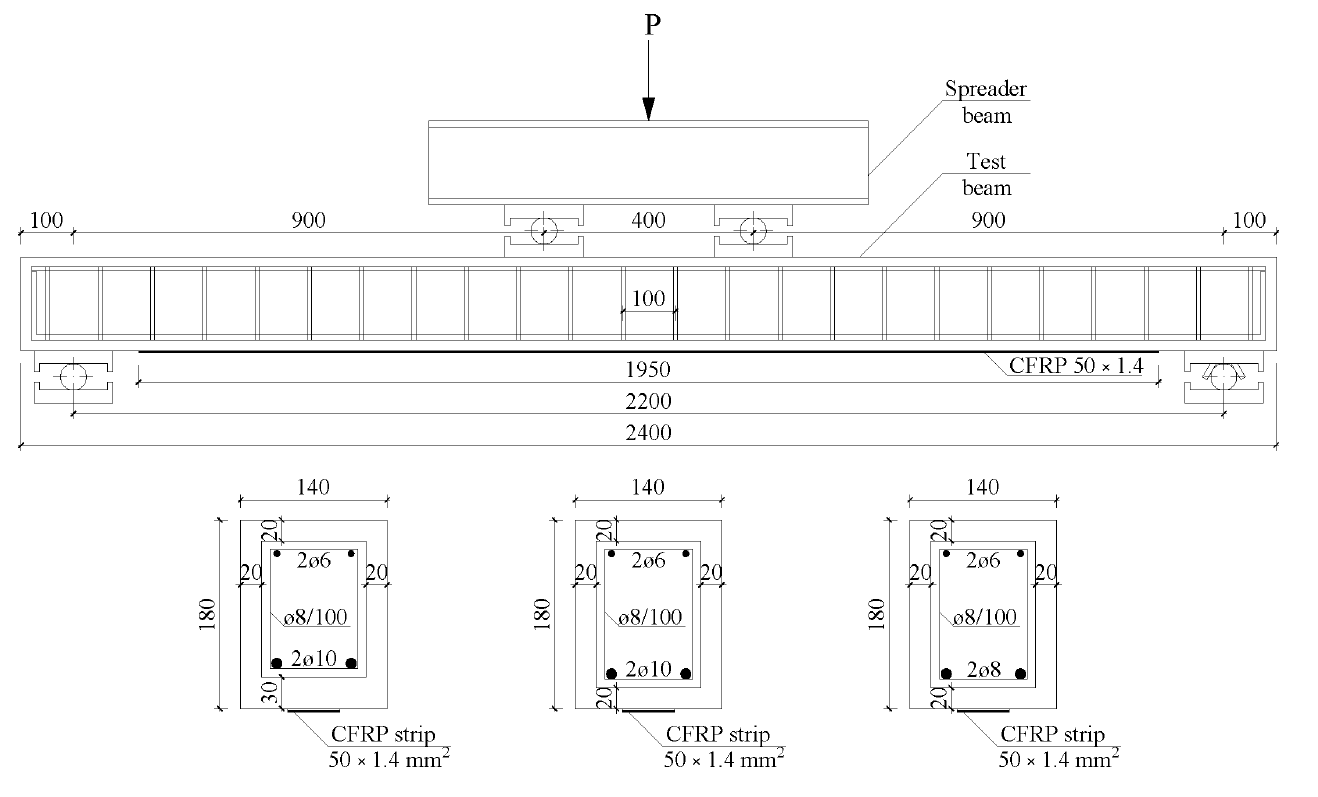
Figure 5. Specimen details (dimensions in mm). Table 2. Material